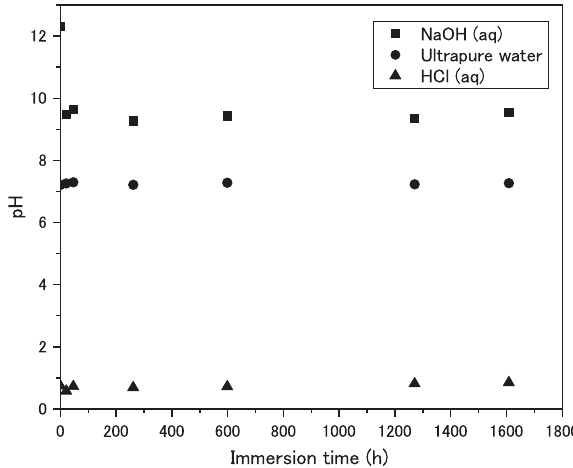
Fig. 1 The pH changes of the solutions of 0.1 M NaOH (aq), ultrapure water, and 0.1 M HCl (aq) in which crushed zircon was soaked.